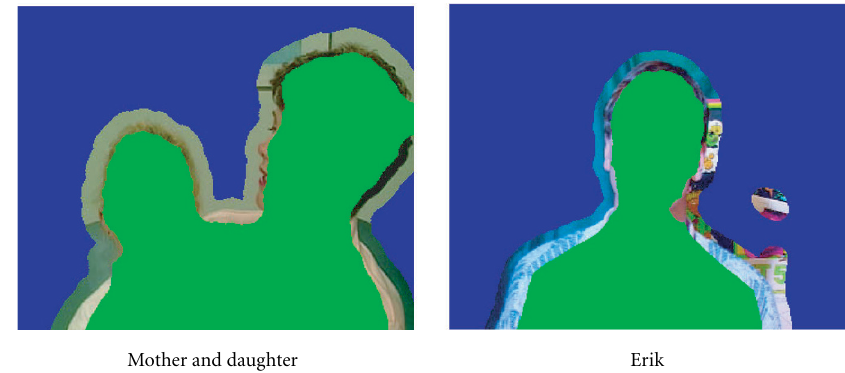
Figure 6: Results on the uncertainty